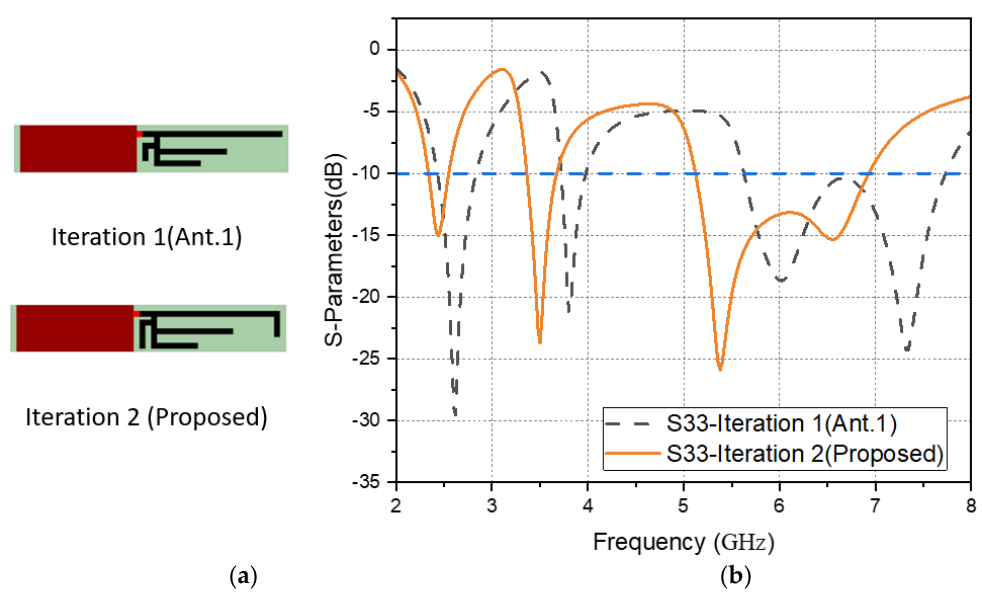
Figure 3. ( a ) Evolution steps of Ant. 3, ( b ) corresponding reflection coefficients (|S33|).